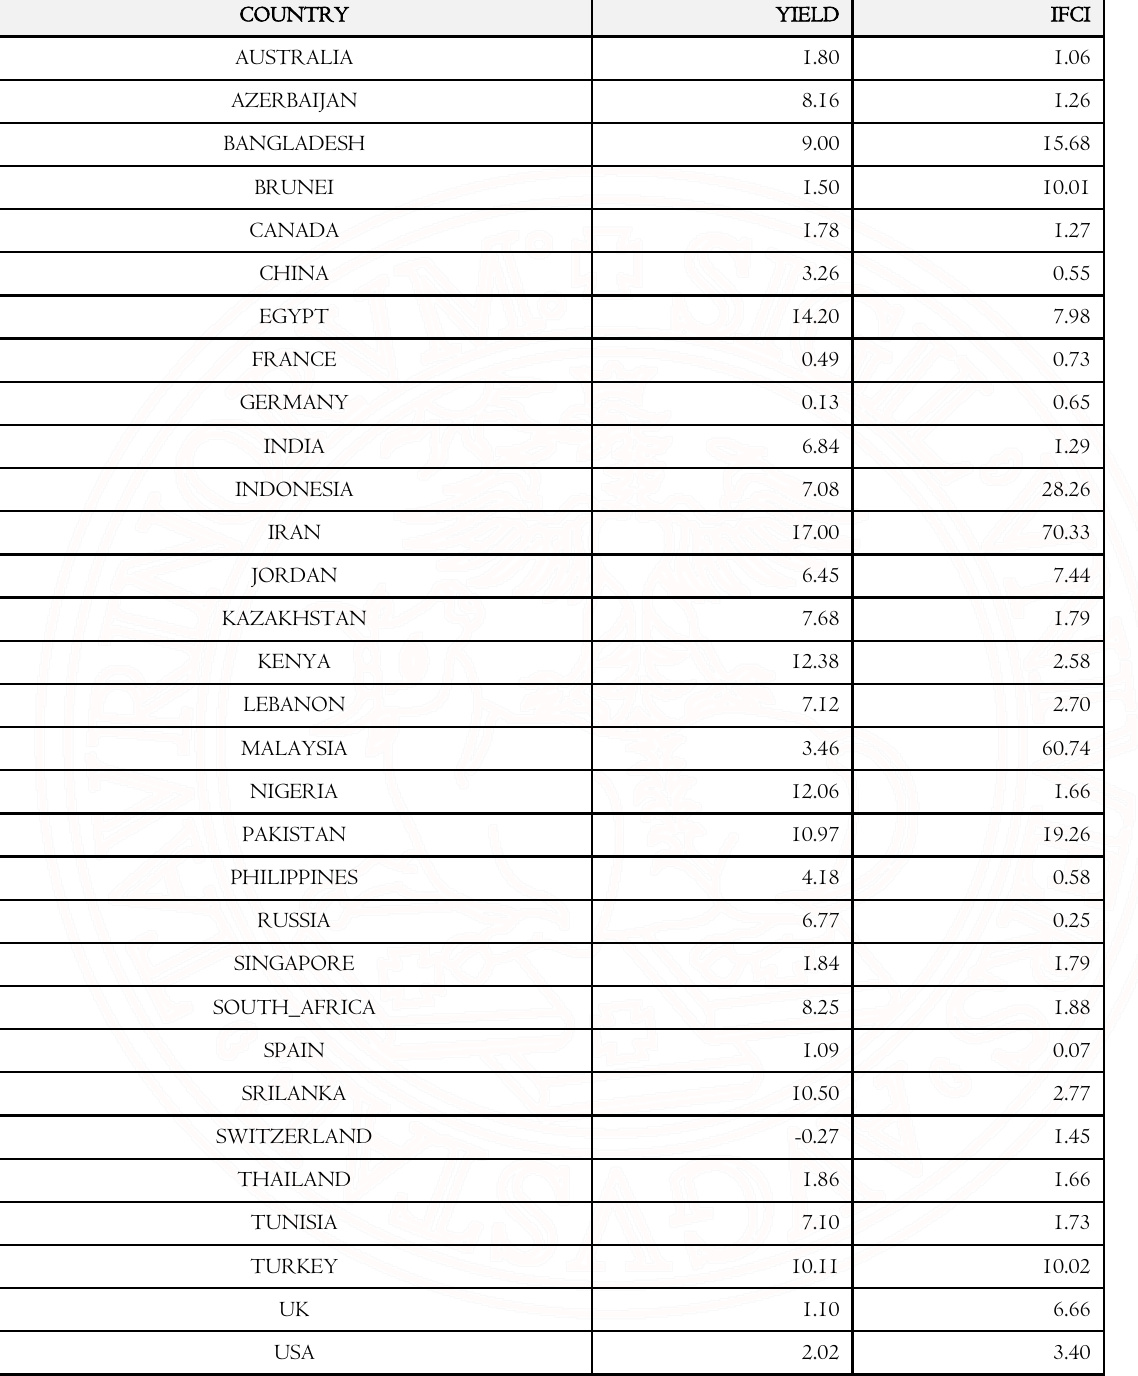
Table II. ICFI Scores and Yields by Country COUNTRY YIELD